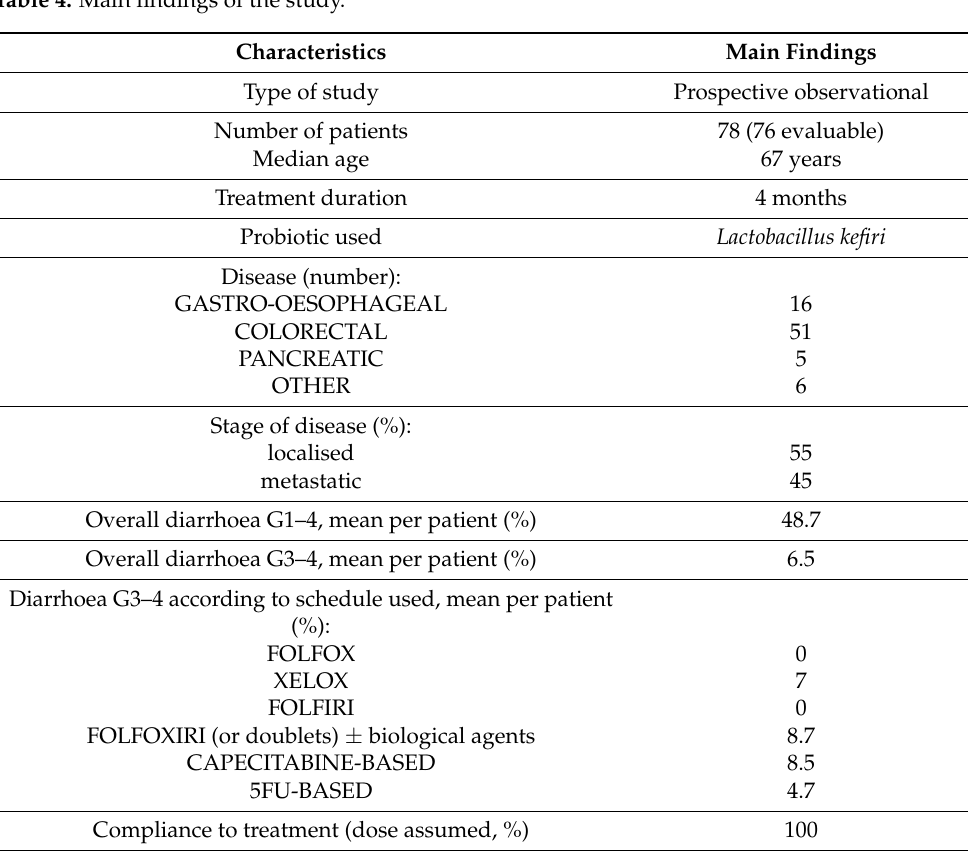
Table 4. Main findings of the